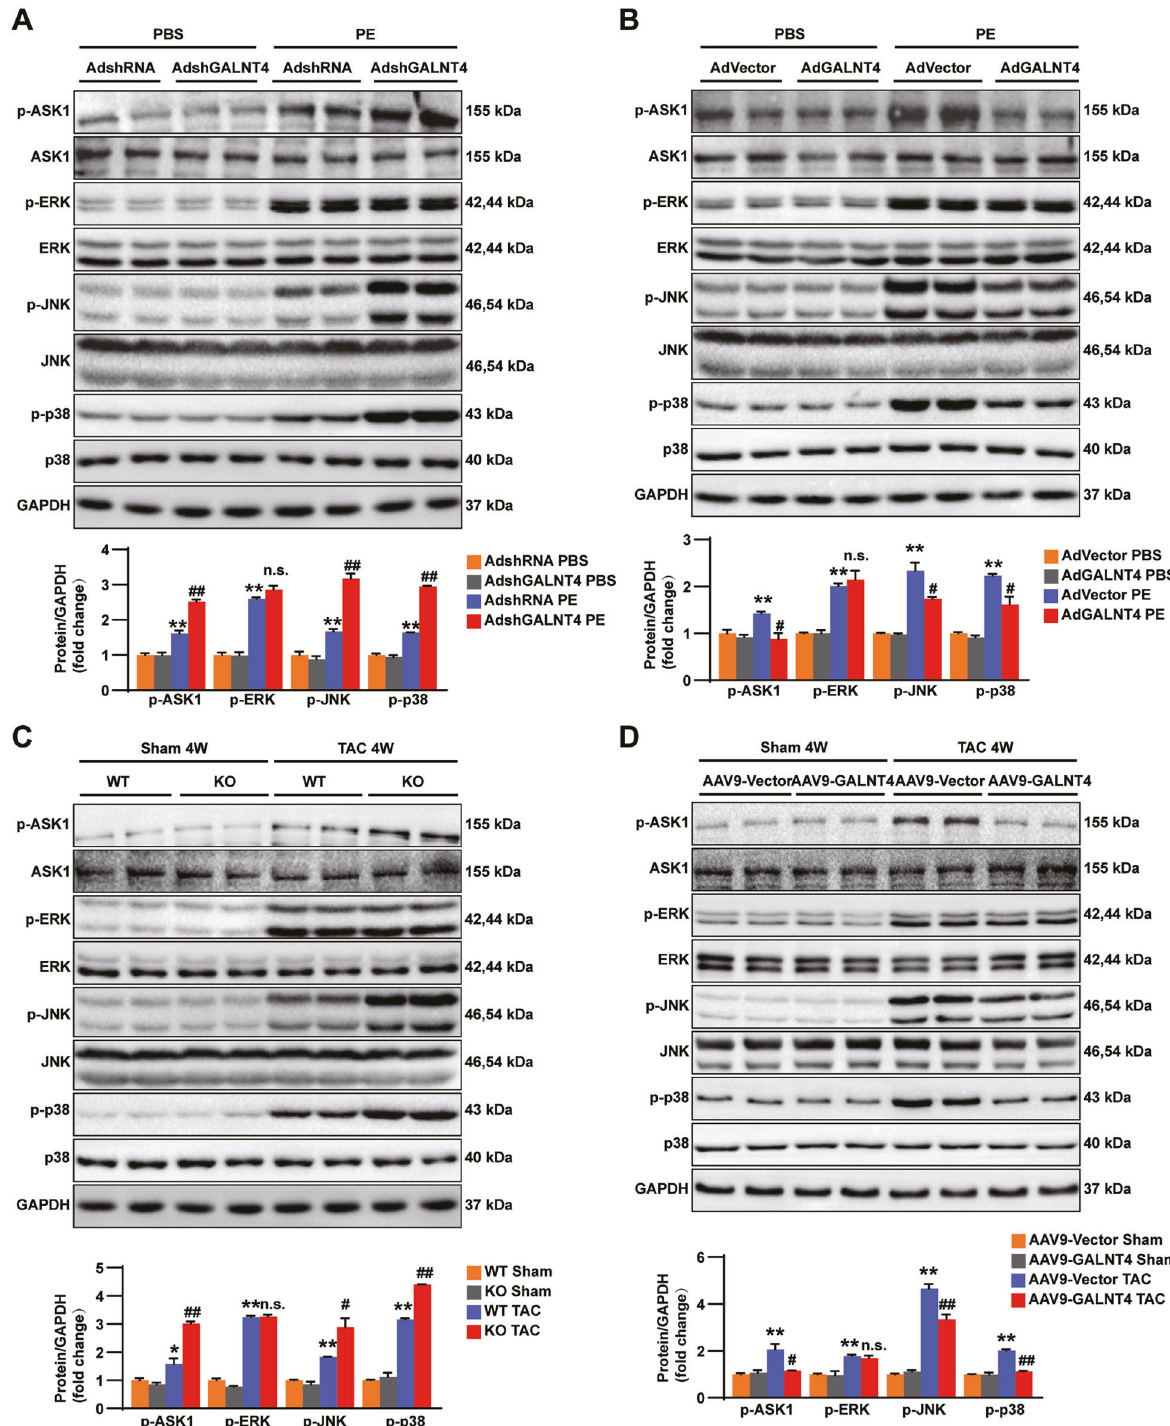
Fig. 5 GALNT4 inhibits the ASK1 signaling pathway. A , B The expression of phosphorylated and total ASK1 and its downstream molecules in cells treated with the indicated adenovirus. A , B ** p < 0.01 vs. AdshRNA PBS or AdVector PBS, # p < 0.05 vs. AdshRNA PE or AdVector PE, ## p < 0.01 vs. AdshRNA PE or AdVector PE, n.s. indicates no signi fi cance. C , D Phosphorylated and total ASK1 and its downstream molecules in mouse hearts in each group subjected to TAC or sham surgery. C , D * p < 0.05 vs. WT sham or AAV9-Vector sham, ** p < 0.01 vs. WT sham or AAV9-Vector sham, # p < 0.05 vs. WT TAC or AAV9-Vector TAC, ## p < 0.01 vs. WT TAC or AAV9-Vector TAC. n.s. indicates no signi fi